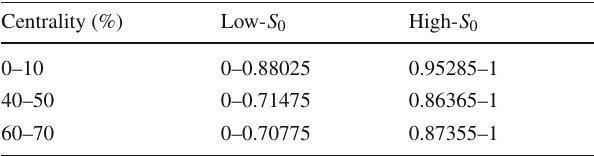
Table1 Lowest20%(low- S 0 )andhighest20%(high- S 0 )cutsonsphe- rocity distribution for Pb+Pb collisions at